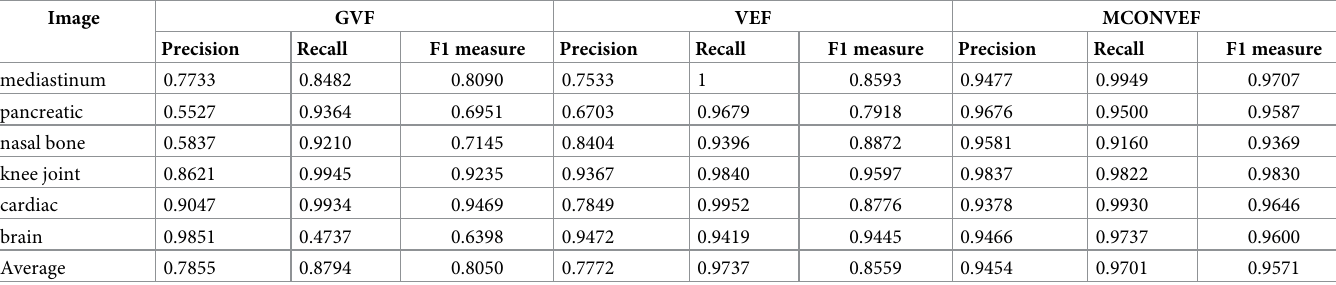
Table 1. The comparison of quantitative indices on medical